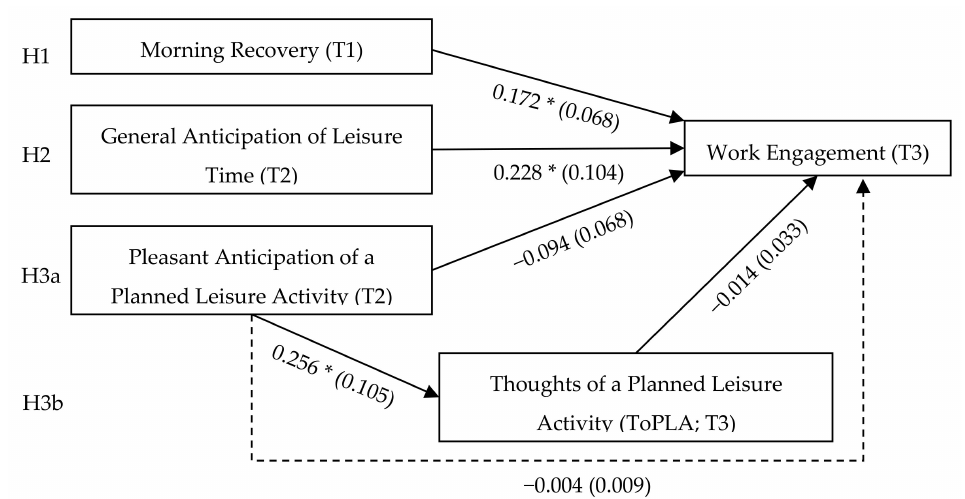
Figure 2. Results from multilevel path analysis. N = 110 employees; 302 matched questionnaires (T1 = morning, T2 = noon, and T3 = afternoon). Results show unstandardized estimates and standard errors in parentheses within persons. The dotted line represents the indirect effect through ToPLA.